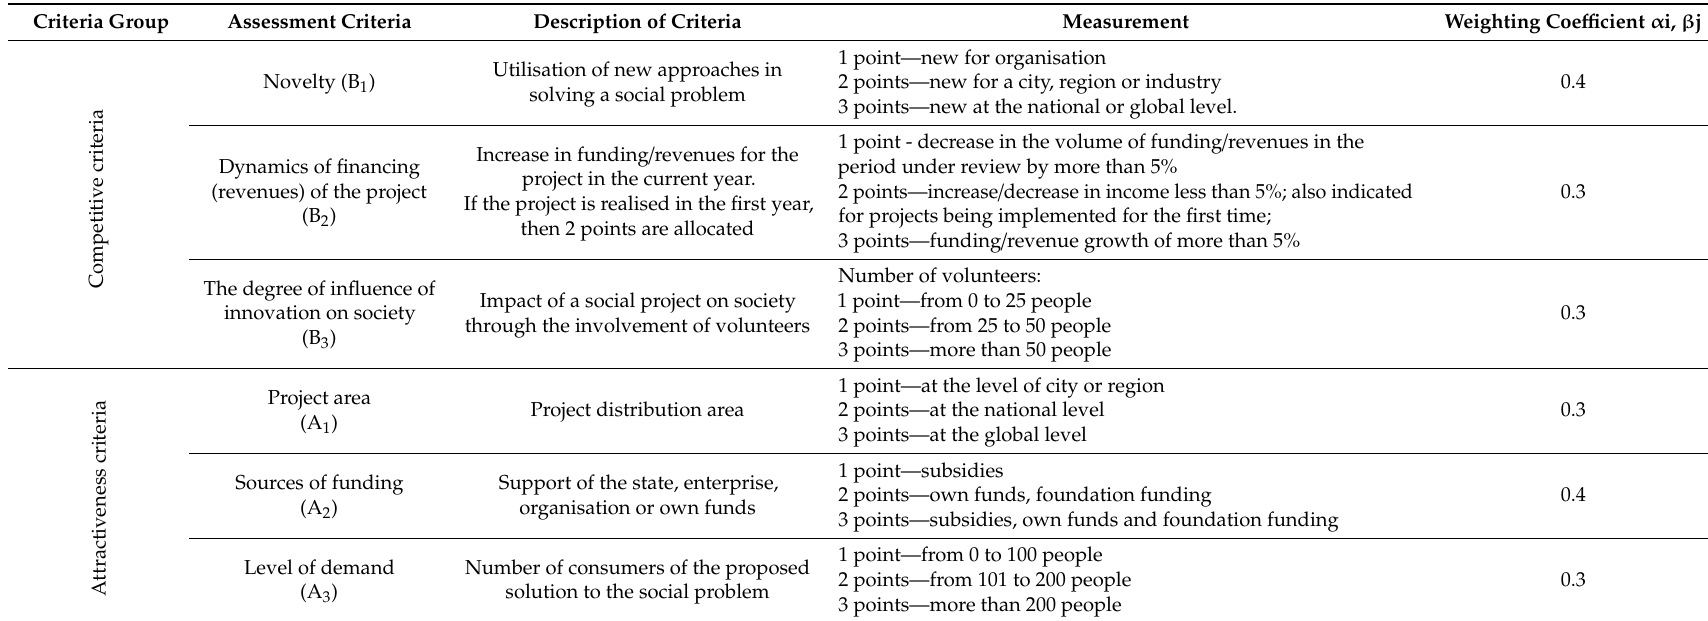
Table 2. Criteria for evaluating socially innovative